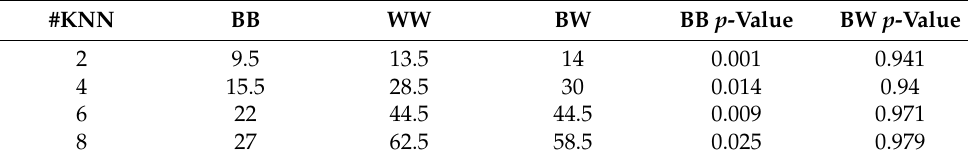
Table 8. Joint count statistics for spatial autocorrelation in India.